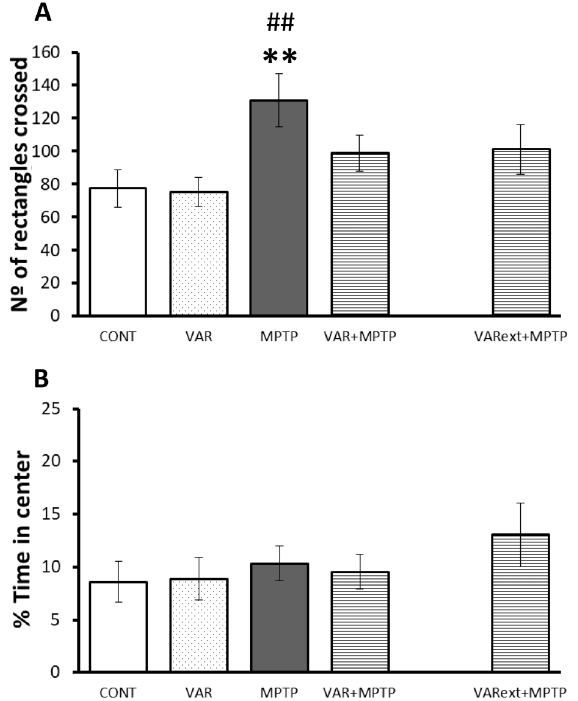
Figure 1. Effects of chronic varenicline exposure on behavior of mice in the open fi eld test in a 1-methyl-4-phenyl-1,2,3, 6-tetrahydropyridine (MPTP) mouse model of Parkinson ’ s disease. Locomotor activity quanti fi ed based on the number of rectangles crossed ( A ) and anxiety levels ( B ) evaluated by percent of time spent in the center of arena. Data are reported as means ± SE.